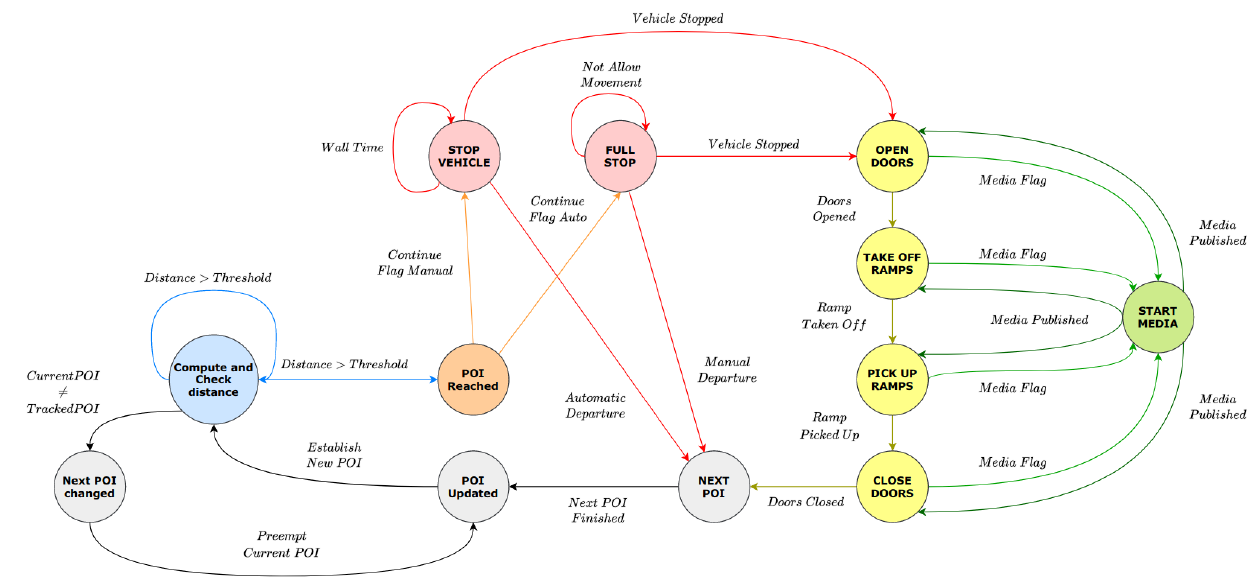
Figure 7. Mission state machine